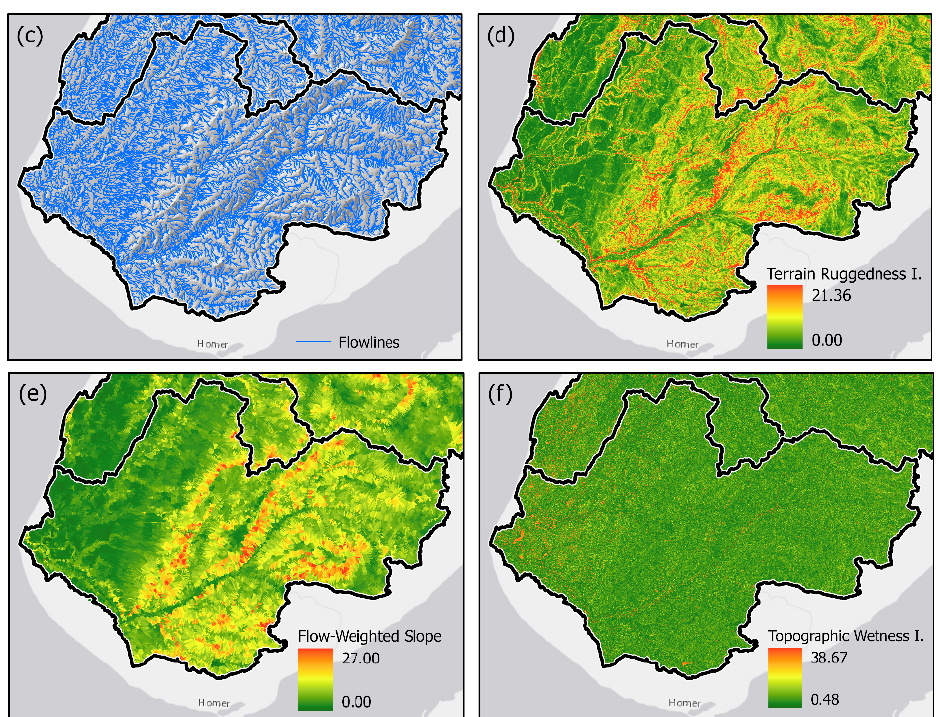
Figure 2. Primary geologic and topographic layers include: ( a ) well log points and modeled aquifer outcrops; ( b ) DEM, represented by a shaded relief to emphasize terrain, with the 67 field points used for training and testing; ( c ) flowlines; ( d ) TRI; ( e ) FWS; and ( f ) TWI. Here, only the Anchor River Watershed, the southernmost of the five watersheds, is shown in full.